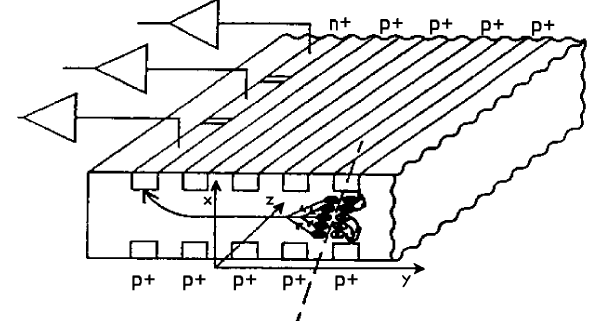
FIG. 71. (Color) Silicon drift vertex detector.